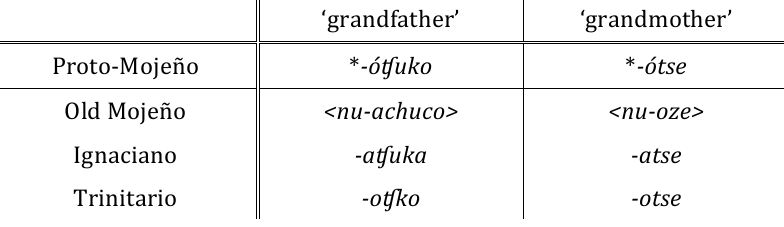
Table 5. Proto-Mojeño etymologies for ‘grandfather’ and ‘grandmother’